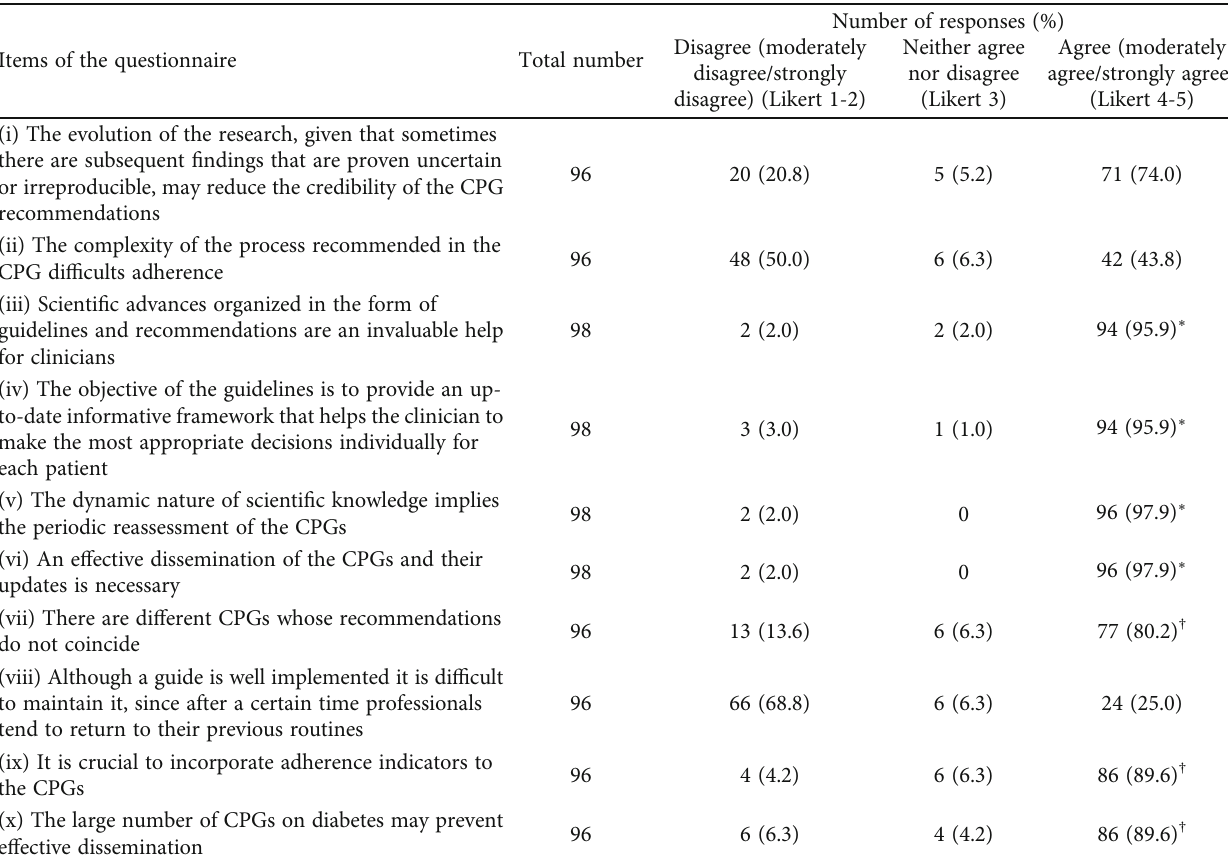
Figure 1: Factors related to not following recommendations of CPGs (scored from 1 = noinfluence to 8 = maximum influence ; data as mean and standard deviation in Table 1: Factors related to clinical practice guidelines (CPGs).